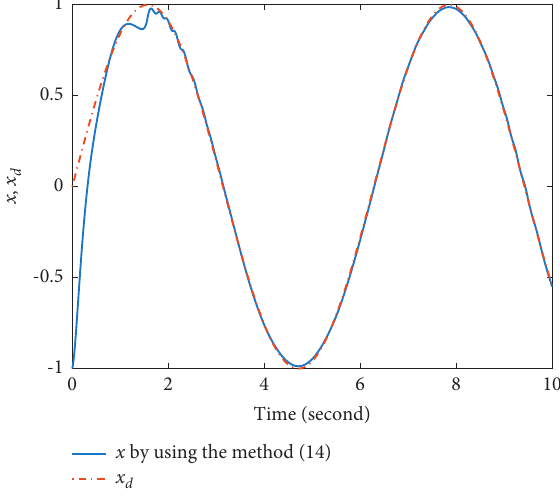
Figure 6: Time response trajectory of controller u by using method ( t ) . (14) under ρ 1